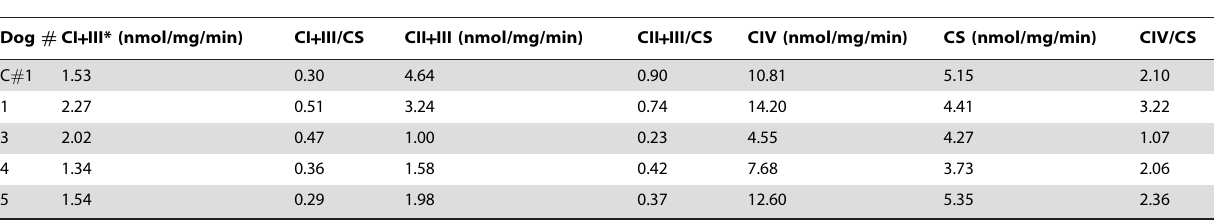
Table 2. Respiratory chain enzyme rates in liver of dogs with AHE.